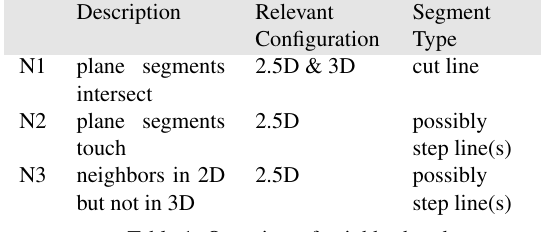
Table 1. Overview of neighborhoods.